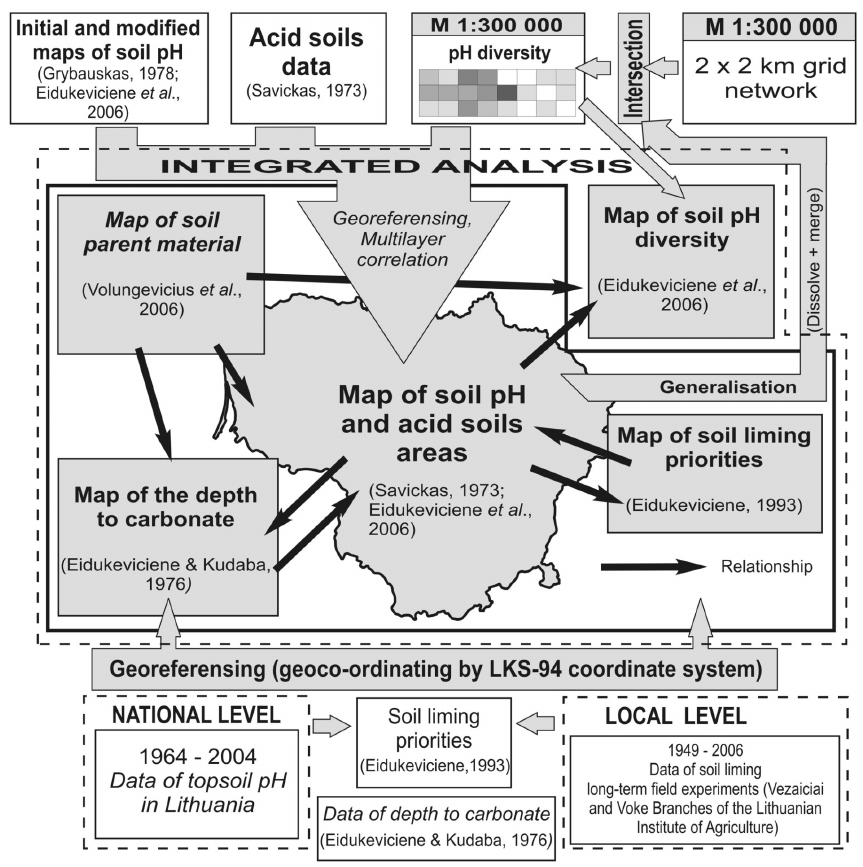
Fig. 1. Methodological scheme of the